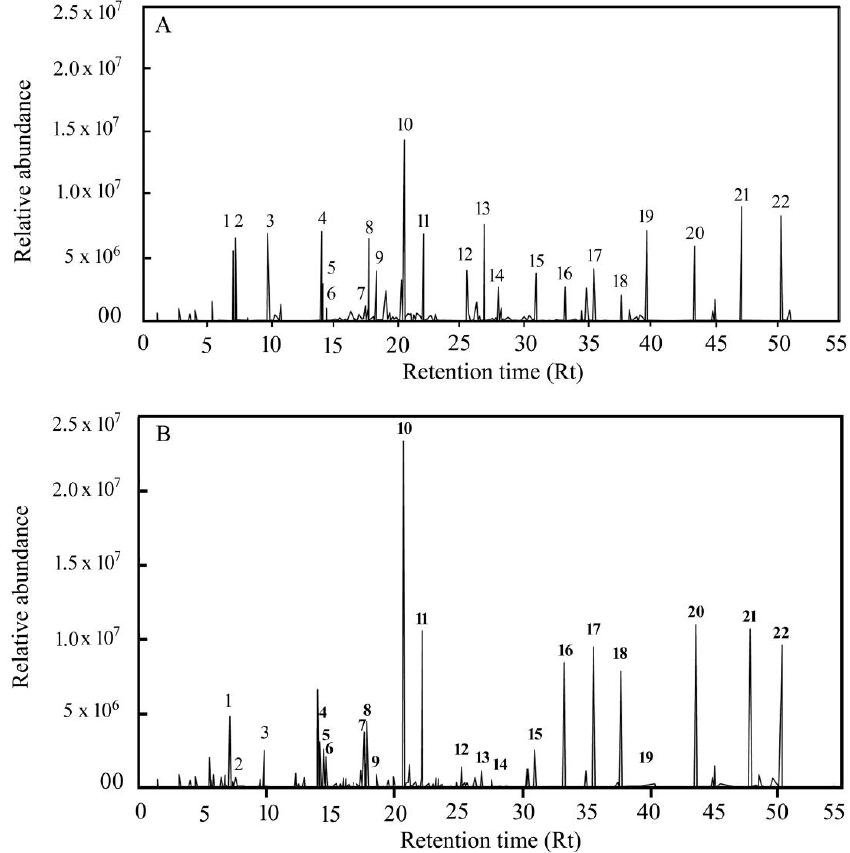
Figure 1. ( A ) Chromatographic profiles of volatiles from the undamaged Cucurbita maxima host plant of Aulacophora foveicollis . The numerical values above the peak denote the peak numbers (Table 1). ( B ) Chromatographic profiles of volatile extracts emitted from the conspecific damaged Cucurbita maxima host plant. Table 1. Volatiles extracted by headspace from undamaged Cucurbita maxima . Peak No.